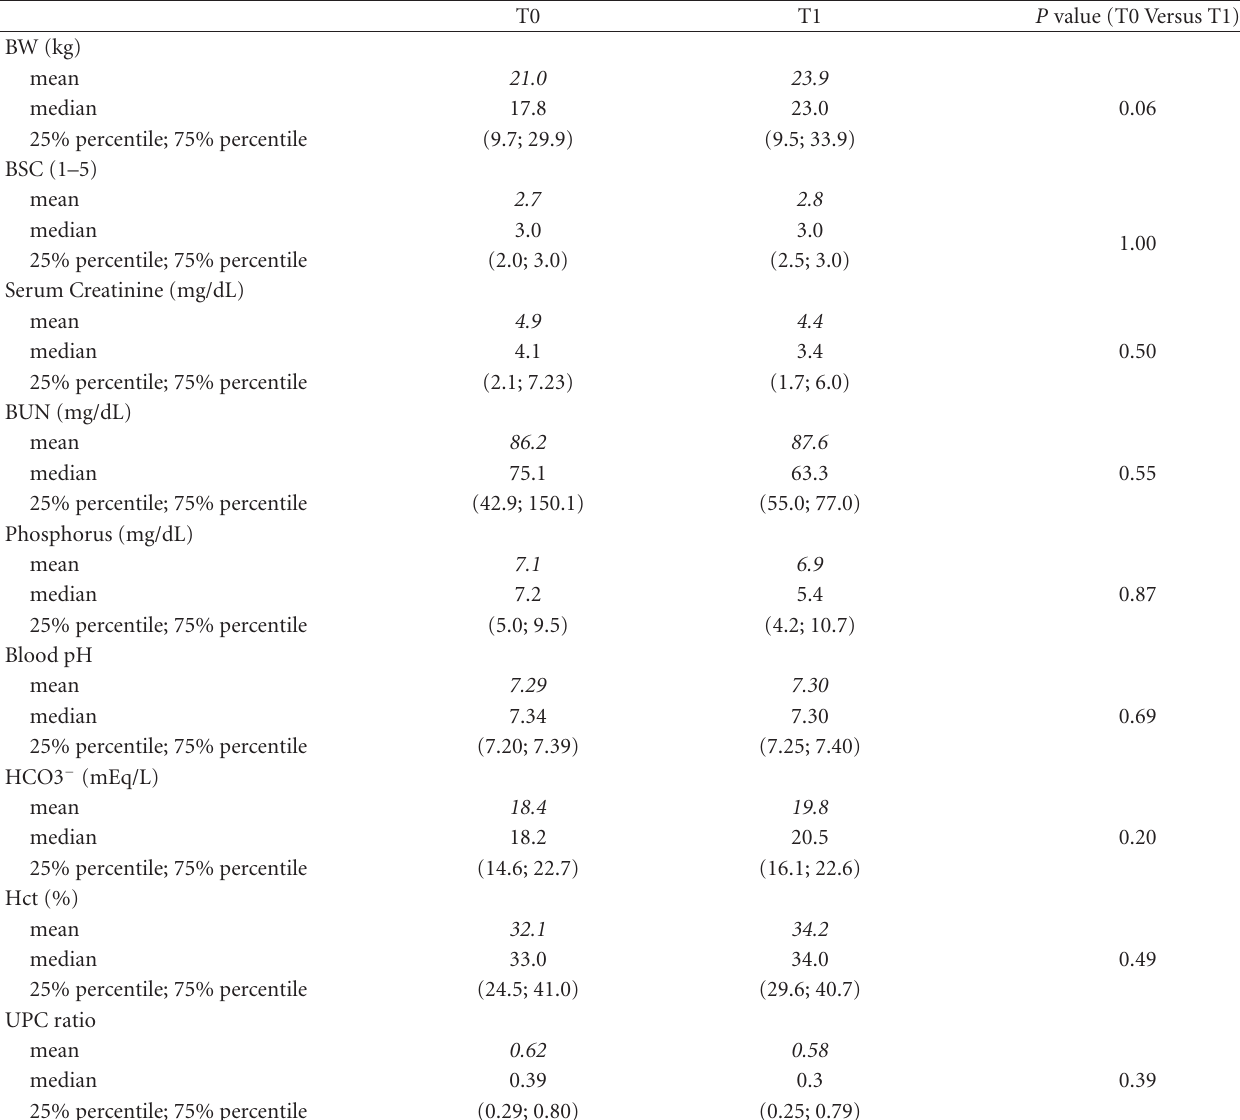
Table 3: Mean, median, and 25% and 75% percentile for BW and BCS, hematocrit, serum creatinine, BUN, phosphate, blood pH, bicarbonate, and UPC ratio, for group B at time of randomization (T0) and after 4–8 weeks (T1) of treatment. Di ff erences between values at di ff erent examinations are depicted by P value (statistically significant P < 0 .